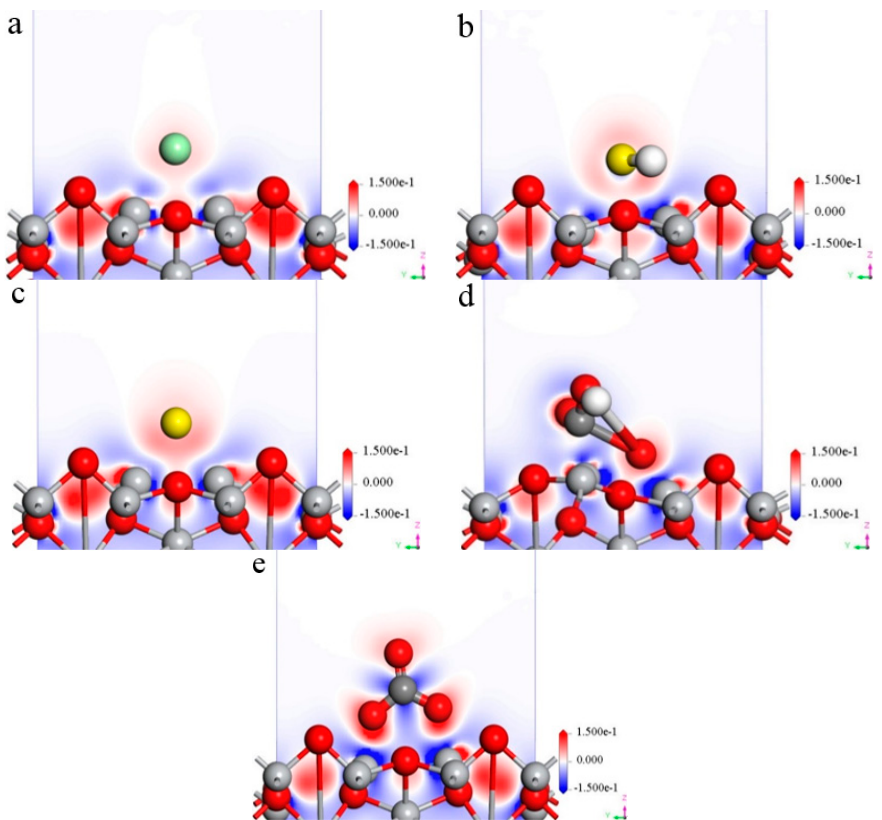
Figure 4. Di ff erential charge density distribution of fi ve ions on the TiO 2 (100) surface at the bridge site. ( a ) Cl − ; ( b ) HS − ; ( c ) S 2 − ; ( d ) HCO 3 − ; ( e ) CO 32 −